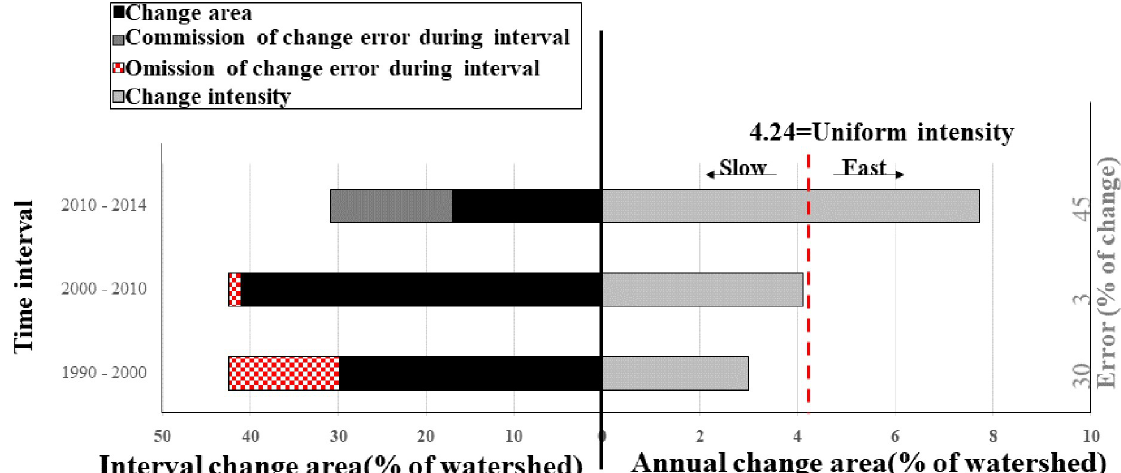
Fig 3. Interval change area along with hypothetical errors that could give reasons for the deviations from UI and yearly change area of the three-time intervals: 1990–2000, 2000–2010 and 2010–2014.